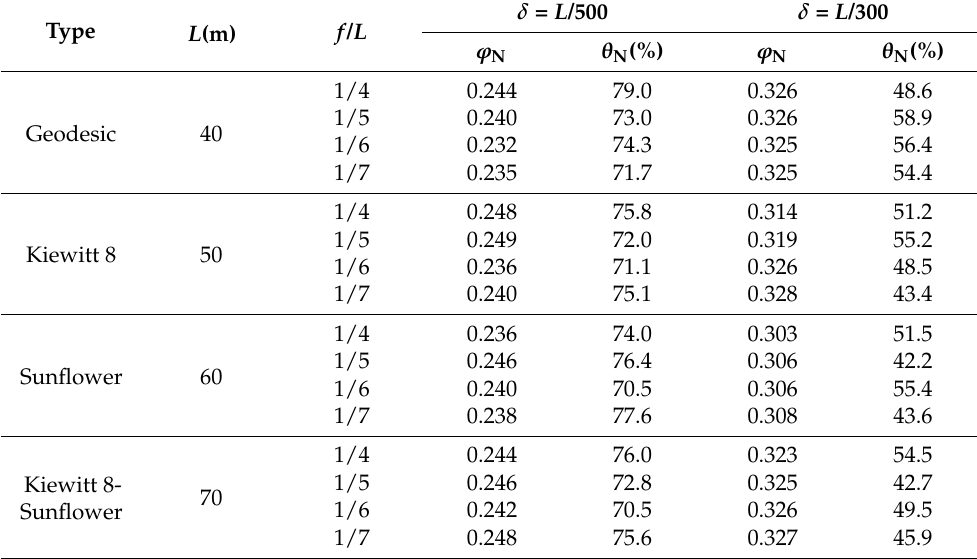
Table 4. The SFS under the IGDM with L /500 and L